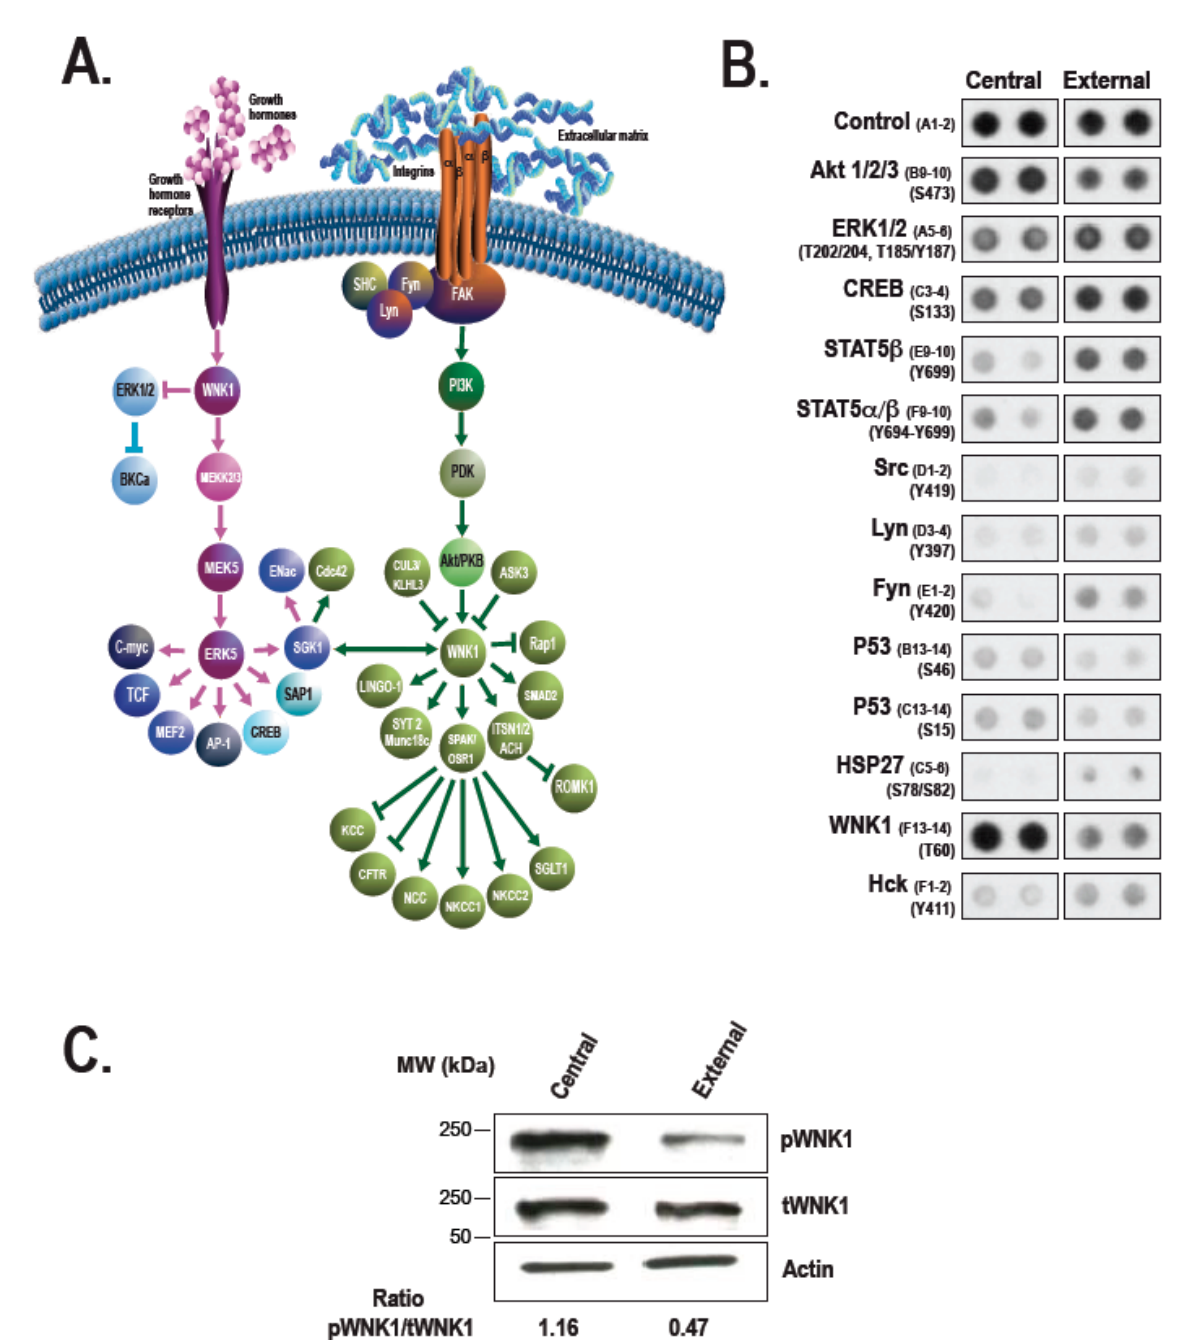
Figure 7. Kinase profiling analysis during corneal wound healing. ( A ) Major protein mediators from the WNK1 signal transduction pathways. ( B ) Cell lysates isolated from the central and external areas of hTECs assembled using hCEC-44, hCEC-52, and hCEC-71 were pooled together and used for the detection of activated kinases with the Human Phospho-Kinase Array from R&D Systems. Kinases and mediators identified as being differentially phosphorylated between the central (wounded) and external (unwounded) areas of hTECs are identified. ( C ) Cell lysates from the central and external areas of wounded hTECs were analyzed by immunoblotting to confirm the phosphokinase array results for the mediator WNK1. Actin was used as the loading control (Figure adapted from Reference [336] with the permission of Journal of Tissue Engineering and Regenerative